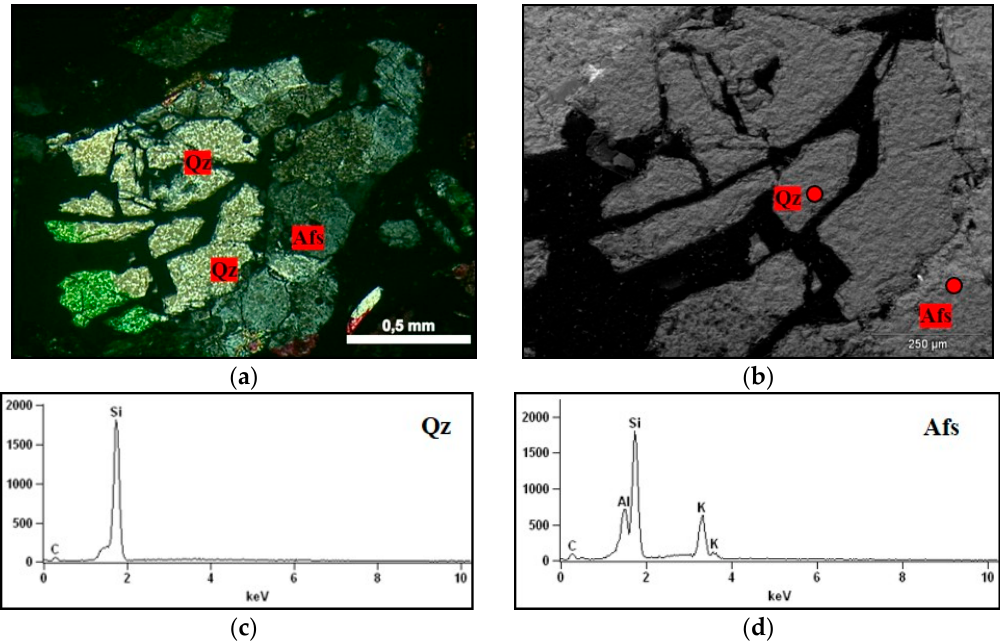
Figure 15. Fragment of the rock in the mortar submitted to the mortar bar test, where: Afs = K- feldspar, Qz = quartz. ( a ) micrographs obtained under optical microscopy under crossed polarizer of the rock showing voids inside the grain of quartz, 5× magnification; ( b ) micrograph obtained in SEM detailing the presence of partially dissolved quartz grains, 130× magnification; ( c , d ) spectra obtained by EDS of the quartz grain, and K-feldspar.